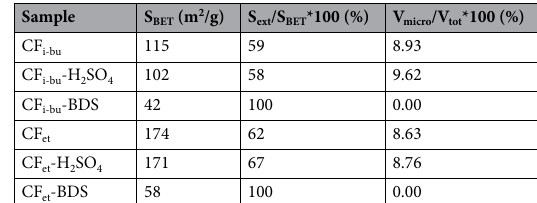
Table 2. Textural analysis of the